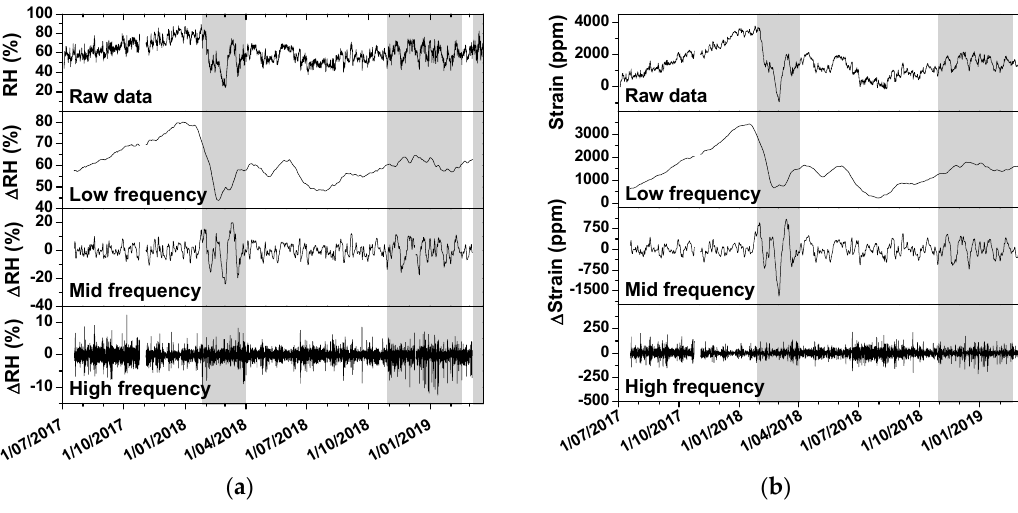
Figure 7. Data of relative humidity ( a ) and wood behaviour ( b ), with isolation of low, mid and high frequencies.